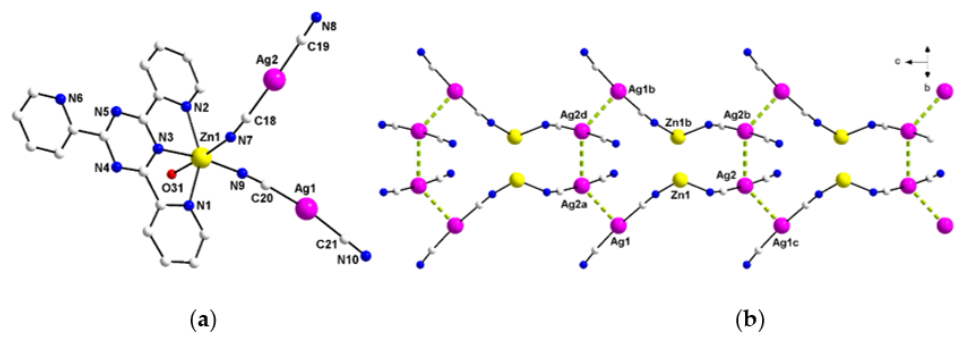
Figure 1. ( a ) Structure of compound 1 ; ( b ) a fragment of the 1-D supramolecular structure of 1 , assembled though H-bonds (light-green dotted lines); symmetry codes: a = x , y , 1 + z ; b = 1 − x , 1 − y , z ; c = x , y , − 1 + z ; d = 1 − x , 1 − y , 1 + z .